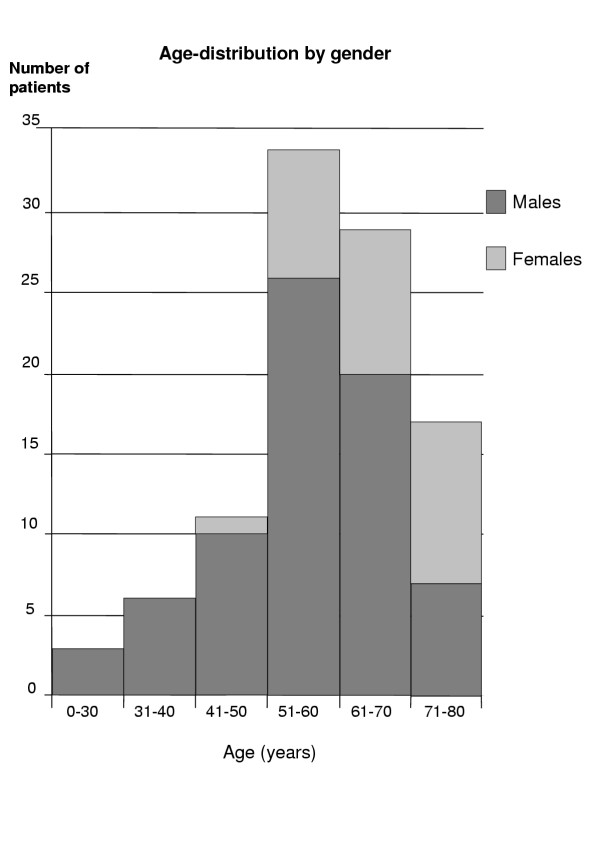
Age-distribution by sex. In the group investigated, the median age was 59.9 (22.4–79.2) years median (range). The women were significantly older than the men.